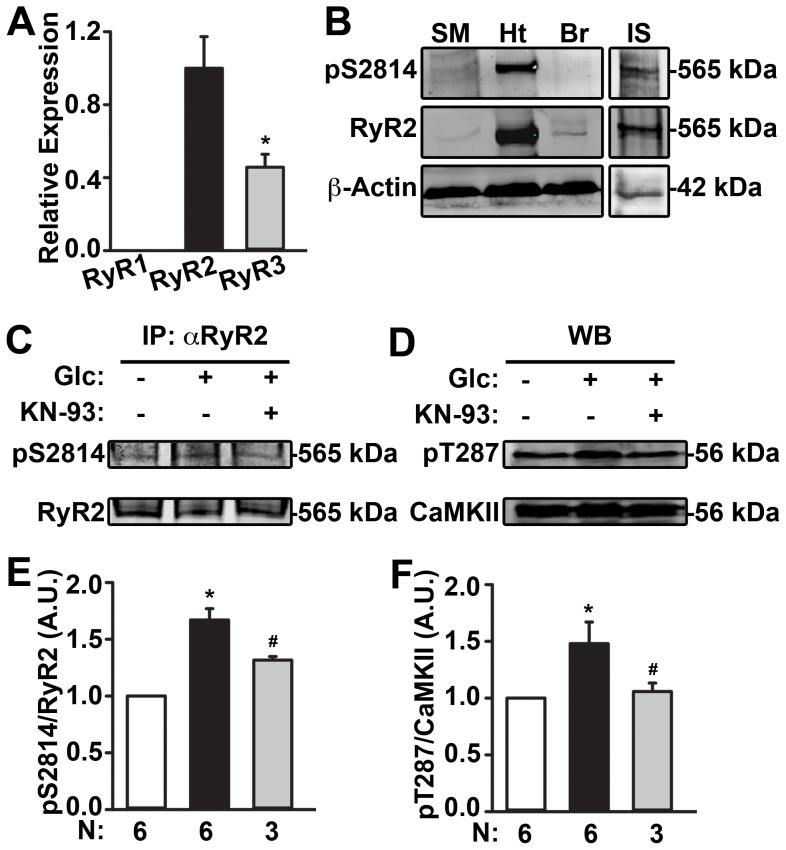
Detection of CaMKII-mediated phosphorylation on RyR2 and determination of its sensitivity to glucose in INS-1 cells.(A) Quantification of qRTPCR analyses showing mRNA transcript levels of RyR1, RyR2 and RyR3 in islets from WT mice (represented in arbitrary units (A.U.)). (B) Representative Western blots for RyR2 expression and phosphorylated RyR2-S2814 in lysates of skeletal muscles (SM), heart (Ht), and brain (Br) from WT mice and rat insulinoma INS-1 cells (IS). β-actin was used to normalize protein concentrations. Observation indicated that RyR2 was present and could be phosphorylated in IS cells, comparable to the Ht. (C) Representative Western blots for RyR2 and its phosphorylation at S2814 from immunoprecipitates obtained from IS lysates using anti-RyR2 antibody. The lysates were prepared from INS-1 cells incubated with 2.8 mM (−) glucose or stimulated with 25 mM (+) glucose with and without pre-treatment with 10 µM KN-93. (D) Representative Western blots for CaMKII and its autophosphorylation at T287 from IS lysates generated in the above experiments. (E) Quantification revealed increased S2814 phosphorylation (pS2814) normalized to total RyR2 level upon glucose (25 mM) stimulation. Pre-treatment with 10 µM KN-93 blunted this increase. (F) Quantification also revealed increased autophosphorylation of CaMKII at T287 (pT287) normalized to total CaMKII level upon stimulation with 25 mM glucose but not in the presence of KN-93. Data (N = 3–6 experiments) are represented as average ± SEM. *P<0.05, vs. 2.8 mM glucose; #
P<0.05 vs. 25 mM glucose.